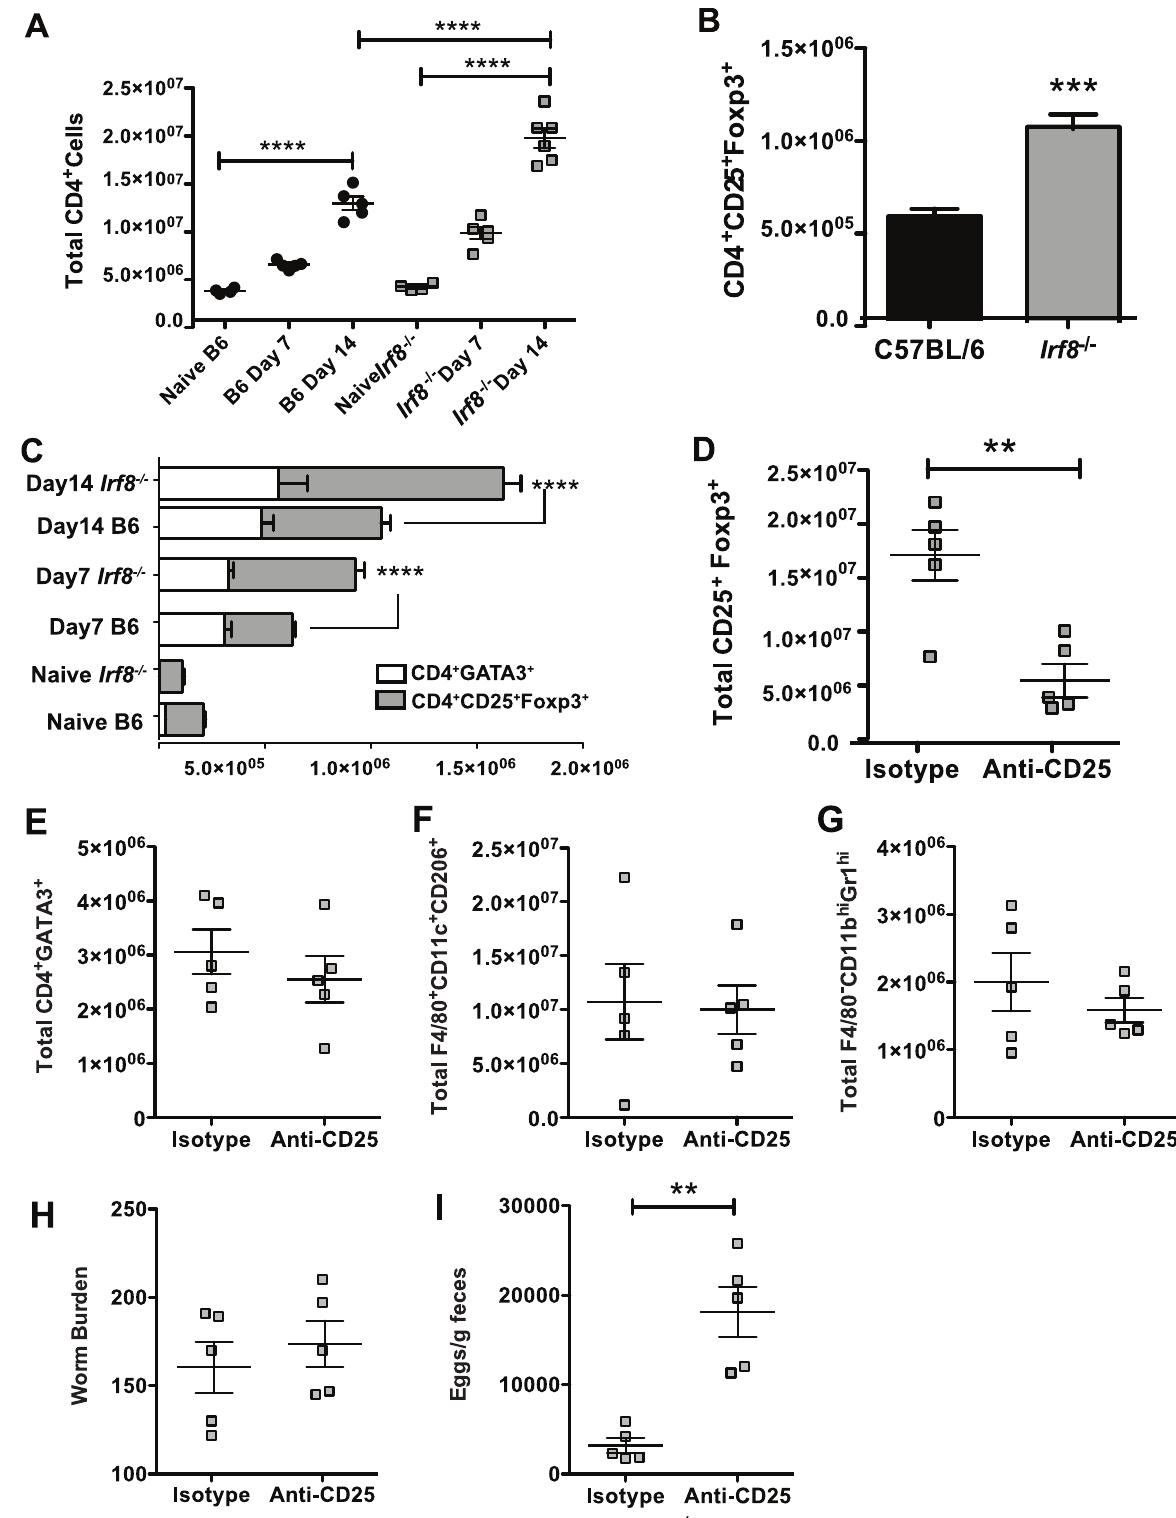
Fig 6. CD4 + CD25 + Foxp3 + T cell expansion is significantly greaterin Irf8 -/- than C57BL/6 mice during Hpb infection. (A) Numbers of total CD4 + T cells in MLN of na ï veand infected C57BL/6(B6) or Irf8 -/- mice on days 7 and 14 p.i. (B) Numbers of CD4 + CD25 + Foxp3 + cells in MLN of infected B6 and Irf8 -/- . mice on day 14 p.i. (C) Numbers of CD4 + GATA3 + and CD4 + CD25 + Foxp3 + T